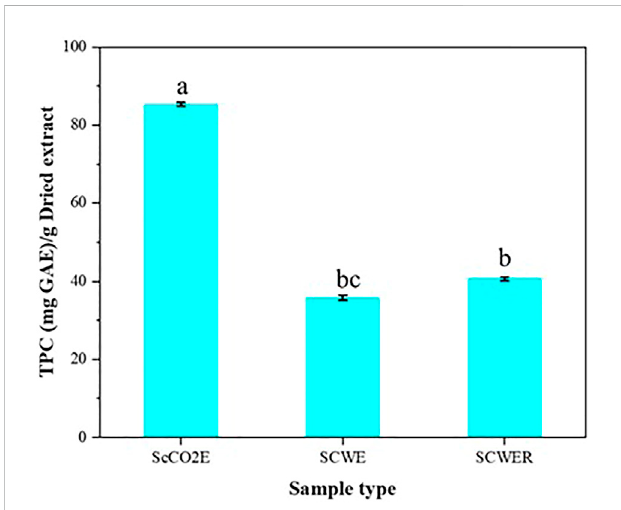
FIGURE 1 Total phenolic contents of the different extracts. The values are representedasmgGAE/gdriedextract.Theerrorbarsshowthestandard deviation between treatments ( n = 3) Different letters on the top of the bar graphs indicate signi fi cant differences ( p < . 05).